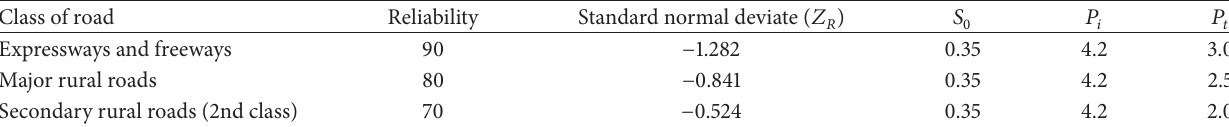
Table 1: Design parameters for different class of roads